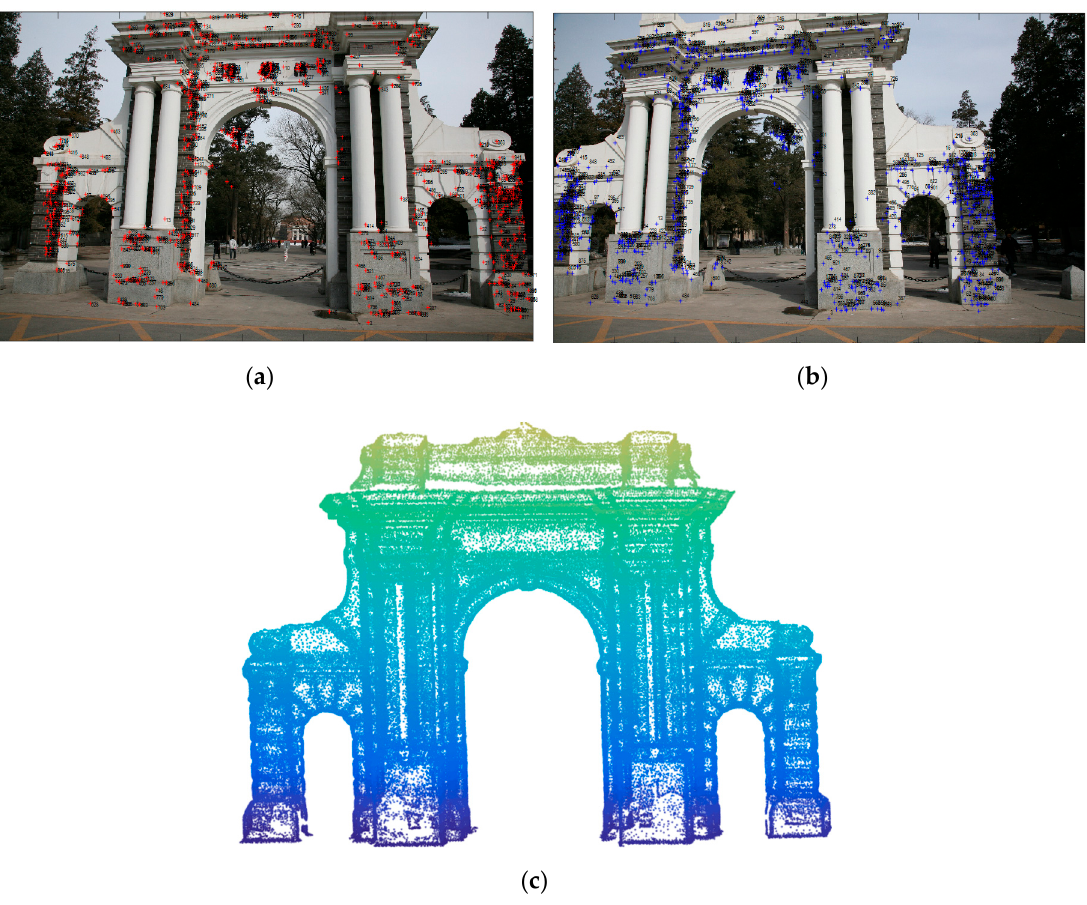
Figure 7. Data source of the real scene 1 . ( a ) Left image and the feature points. ( b ) Right image and the feature points. ( c ) Scanned groundtruth point clouds. The feature points with the same number on the left and right images represent a pair of matching points.